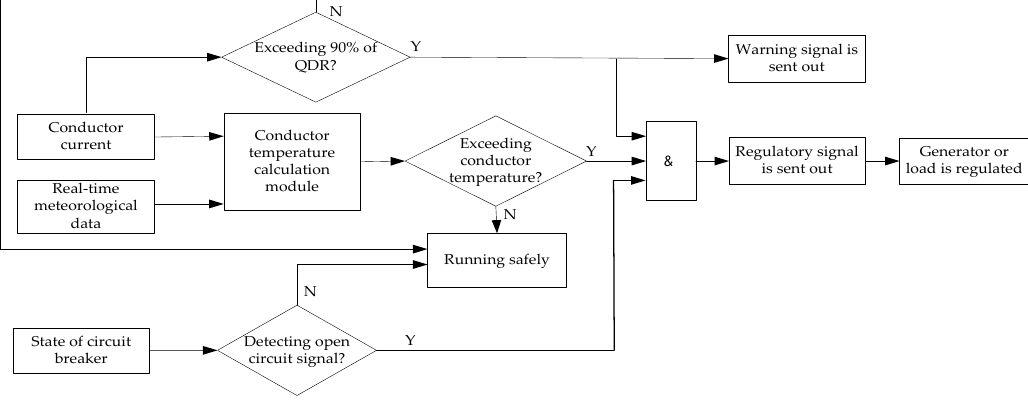
Figure 5. Design of transmission congestion management based on quasi-dynamic thermal rating.